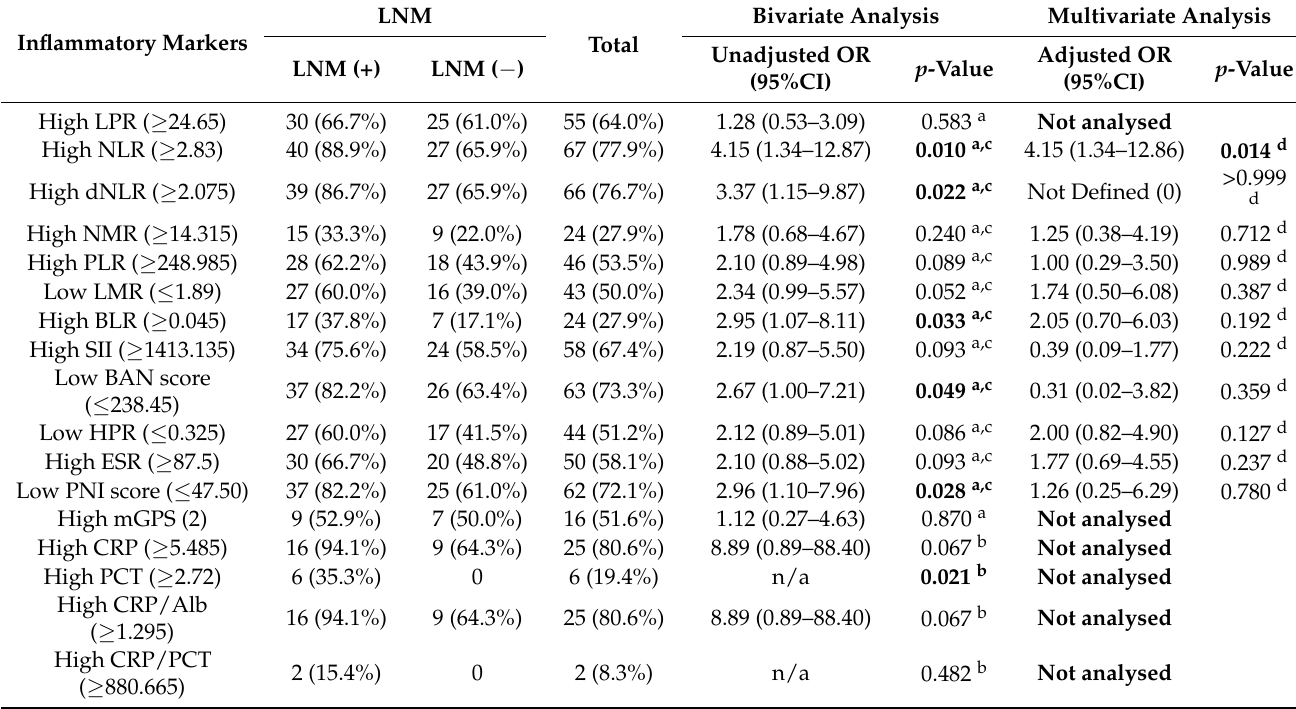
Table 6. Performance of inflammatory markers using their tailored cut-offs associated with lymph node